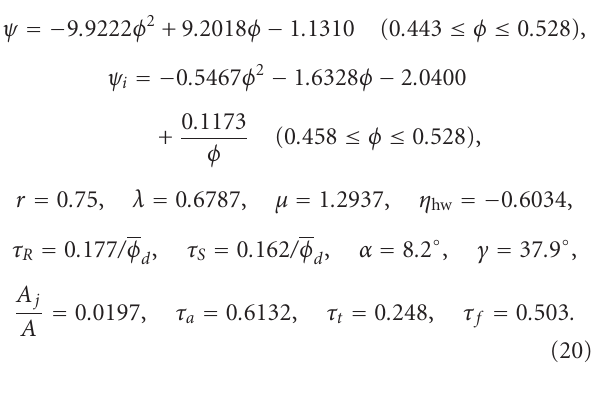
Figure 6: Actuator/compressor characteristics at several mean in- jection rates with closed-loop control (lowest solid line is fit of speedline for baseline